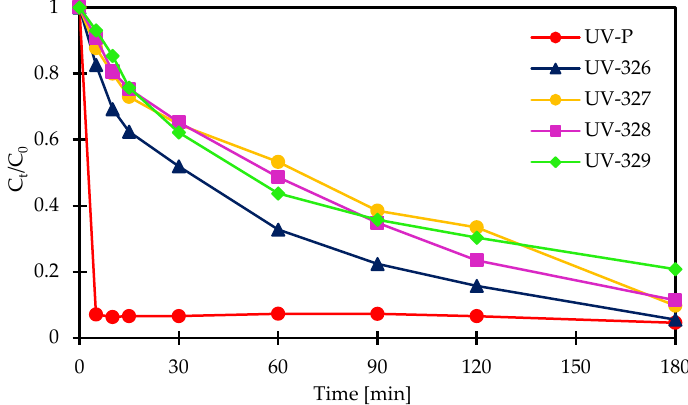
Figure 5. Kinetics of BUVs’s degradation in Co 2+ /PAA process. Reaction conditions: [PAA] 0 = 40 mg/L, [Co 2+ ] 0 = 8·× 10 − 4 mol/L, initial pH 4.5.